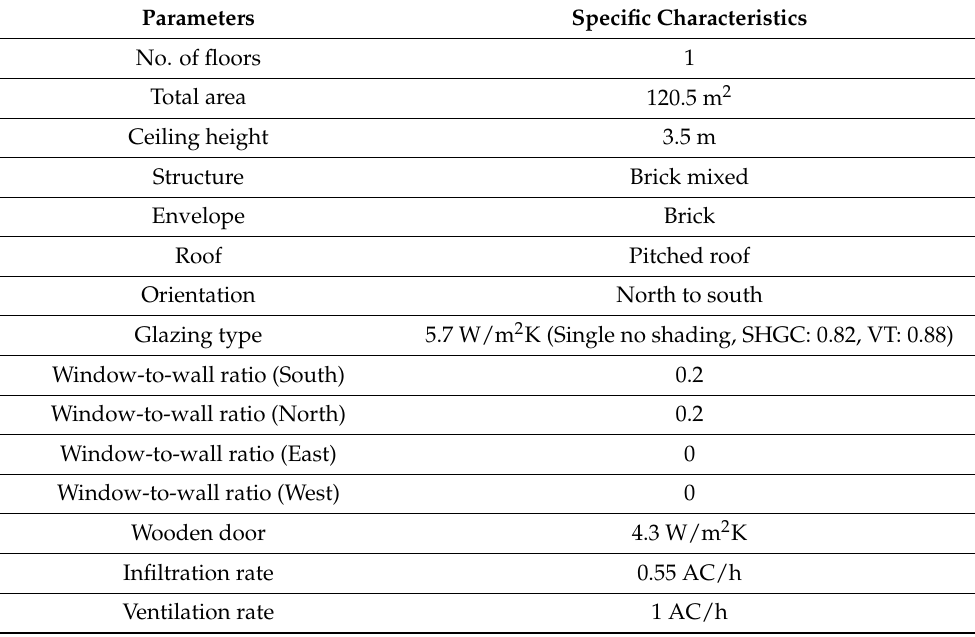
Table 4. Specific construction characteristics of the typical rural house in